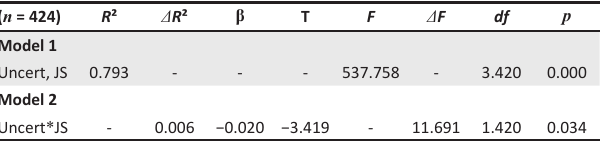
TABLE 8: The moderating role of job satisfaction on the relationship between uncertainty and organisational